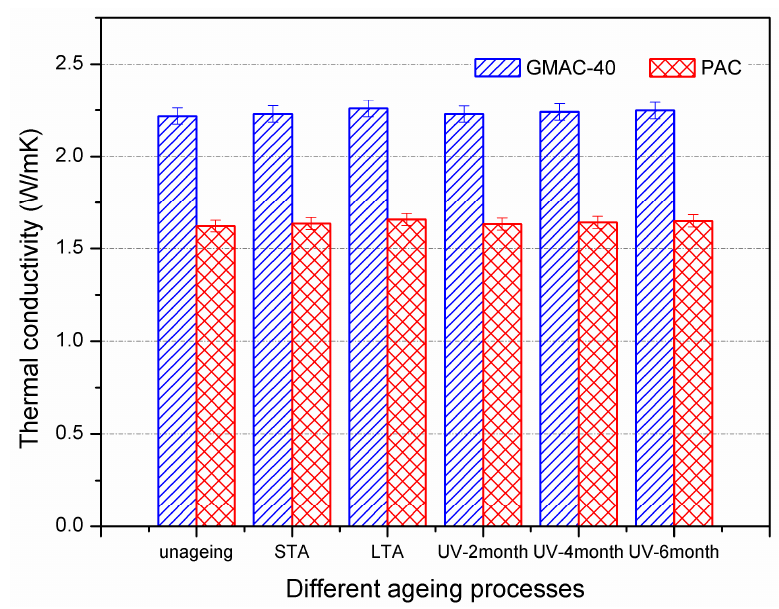
Figure 10. Effect of aging on thermal conductivity of control and conductive asphalt mixtures.